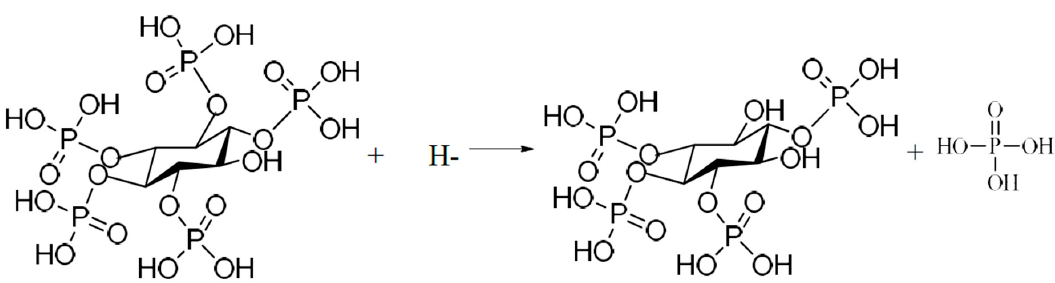
Figure 10. The second hydrolysis step of phytic acid during MAO.